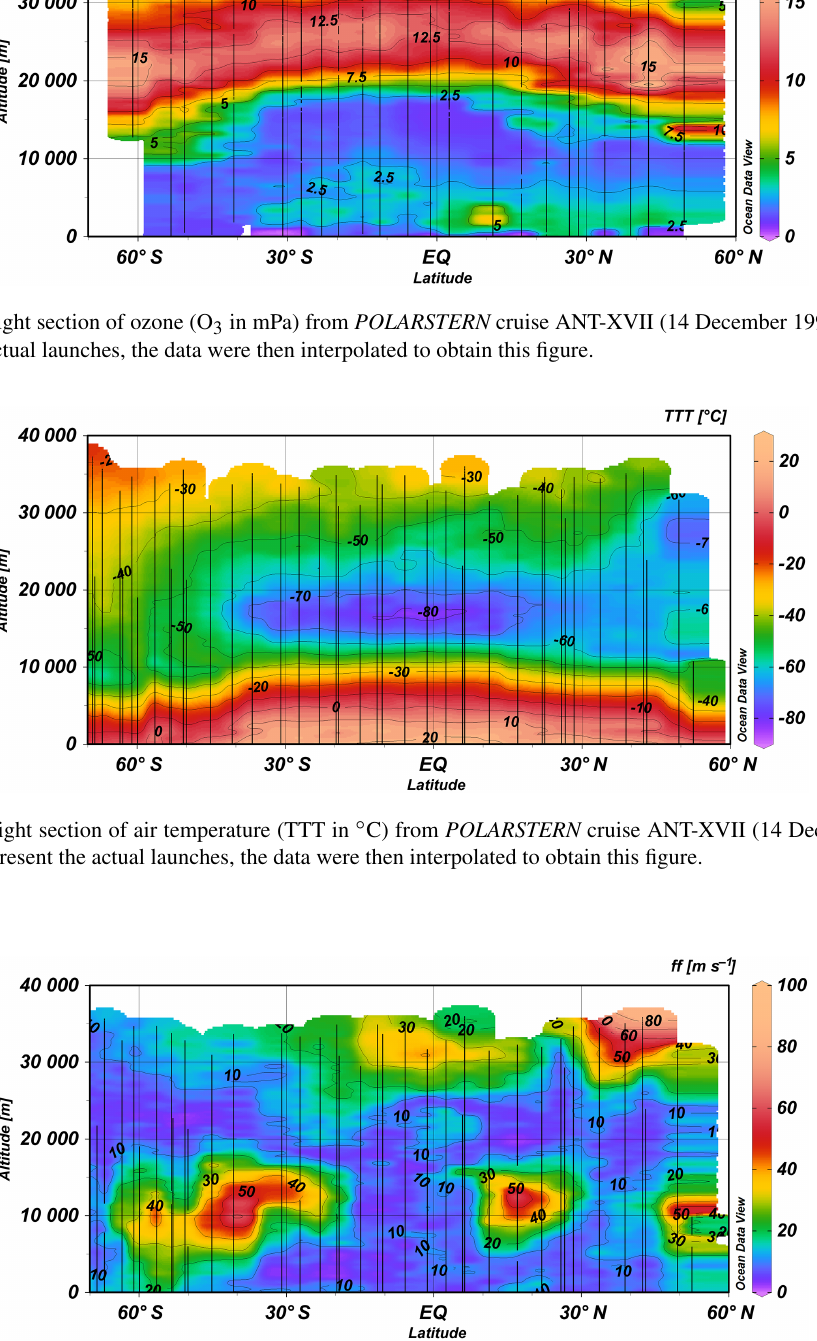
Earth Syst. Sci. Data, 8, 213–220, 2016